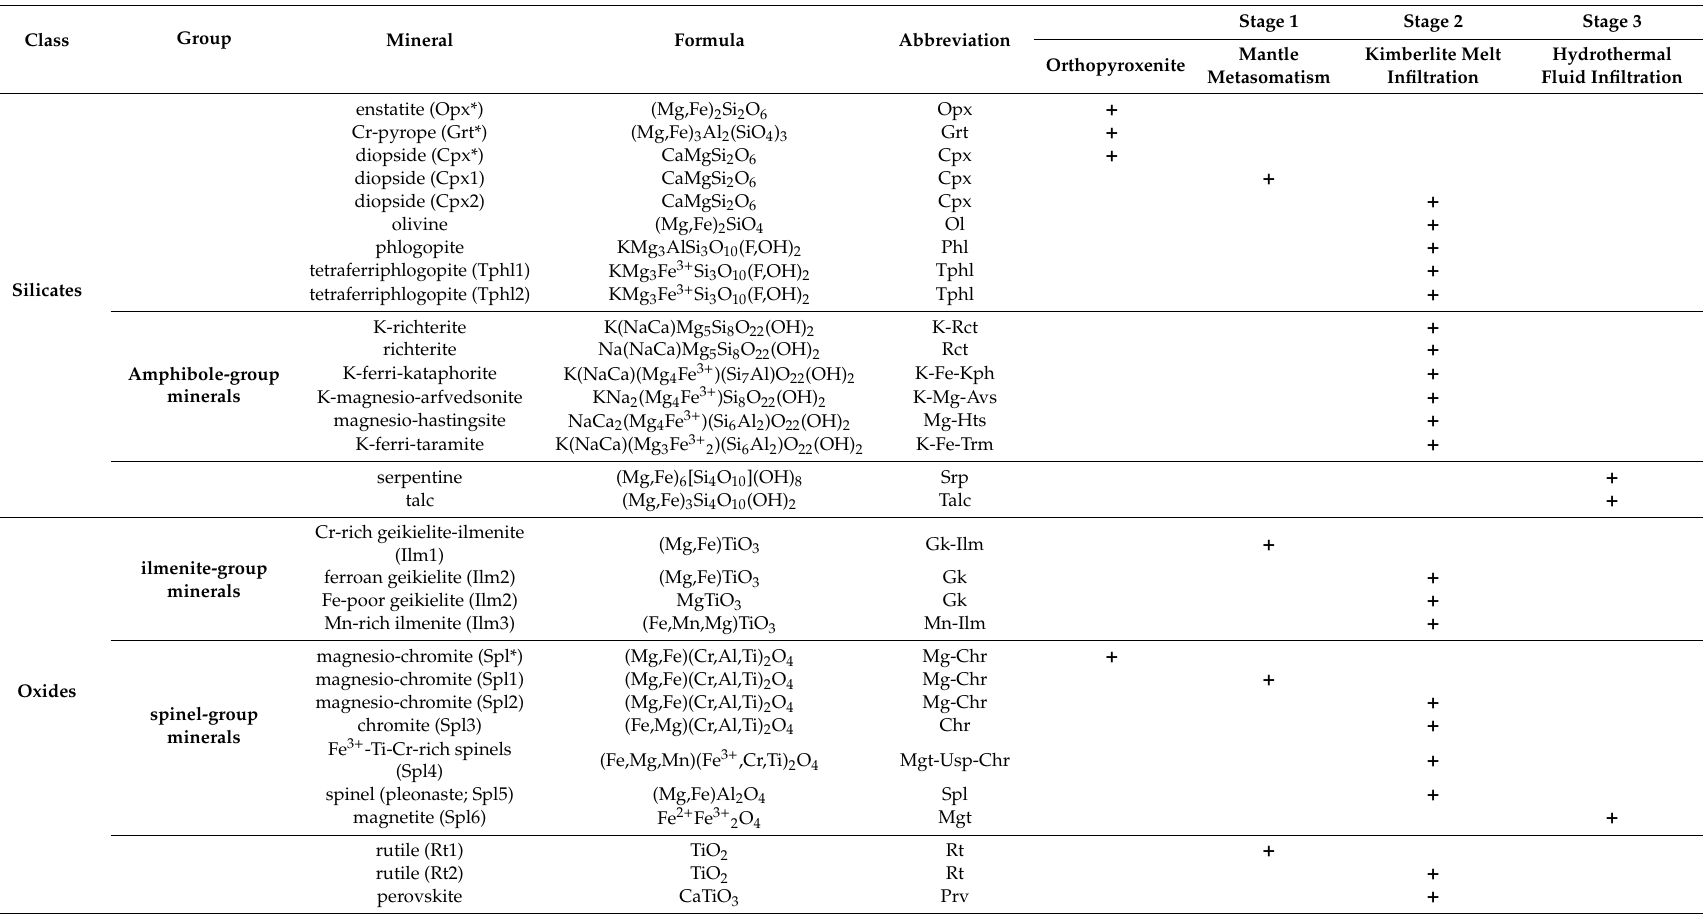
Table 1. An integrated paragenetic scheme showing all the examined minerals and their a ffi liation to a specific process during the rock